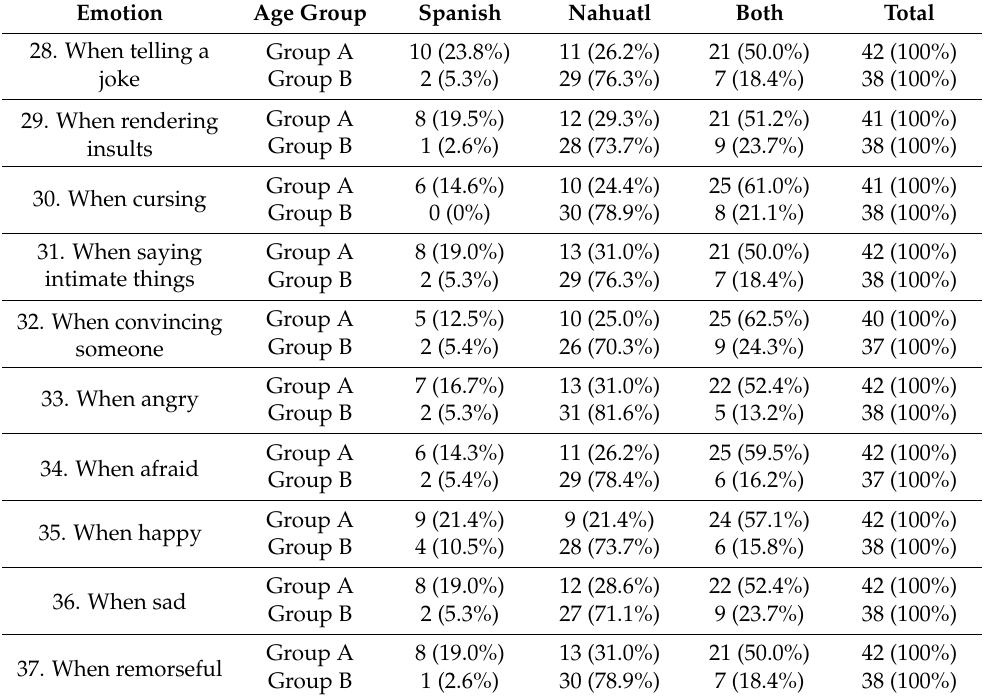
Table 4. Language use in emotional states by age group.